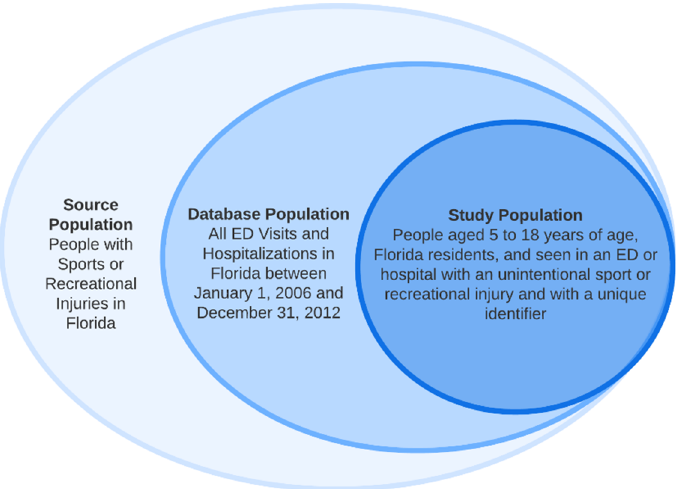
Figure 1: Population hierarchy of the longitudinal sports and recreation injury